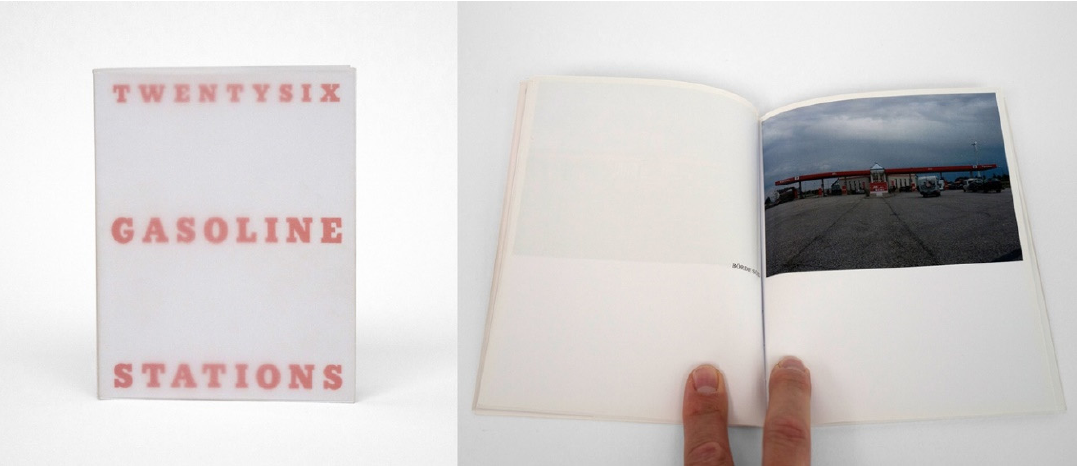
Figure 16. Michalis Pichler, Twentysix Gasoline Stations , 2009.